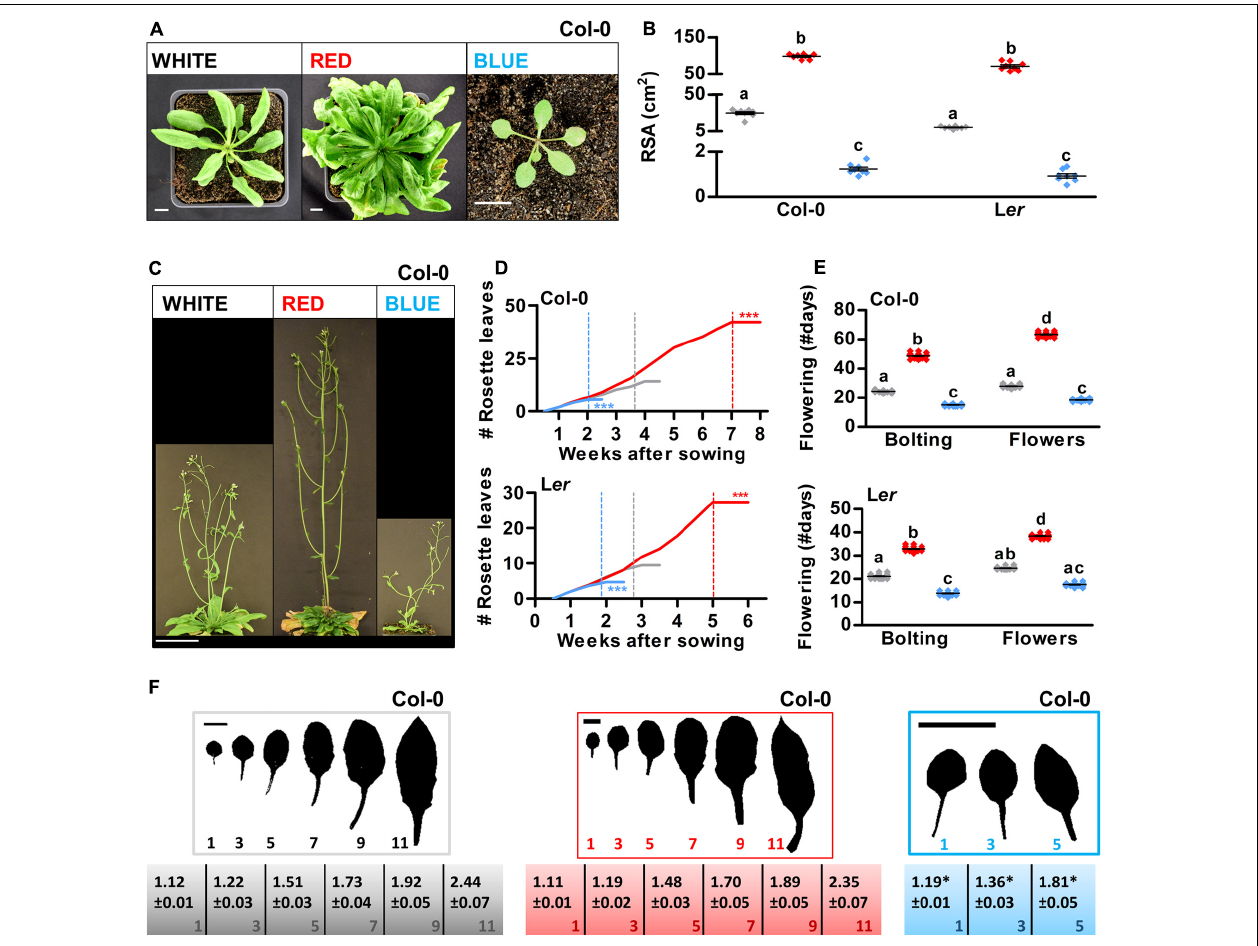
FIGURE 4 | Developmental phase transitions in Arabidopsis are promoted by blue light and delayed by red light. (A) Rosette phenotype of representative Arabidopsis plants of ecotype Columbia (Col-0) grown in white, red, or blue LED conditions. (B) Quantification of rosette surface area (RSA) of Col-0 or Landsberg erecta (L er ) plants as shown in ( A and Supplementary Figure S4B ), respectively. (C) Representative Arabidopsis Col-0 plants grown in LED conditions until 1 week after flowering. (D) Rosette leaf appearance in Col-0 and L er plants over time. (E) Flowering time (until bolting, or until the appearance of flower buds) of Col-0 and L er plants in number of days. (F) Rosette leaves of representative Col-0 plants and length/width ratios of the leaf blade ( ± SE, n = 10). Scale bars represent 1 cm in (A , F) , and 10 cm in (C) . Graph colors represent the LED conditions in (B,D,E) . LED conditions and ecotypes were compared using a one-way ANOVA followed by a Tukey’s test (letters a–d indicate statistically significant differences, p < 0.05) in (B,E) . In (D,F) , monochromatic LED conditions (red or blue) were compared to white (control) using a two-sided Student’s t -test [asterisks indicate significant differences (* p < 0.05, *** p < 0.001)]. Error bars represent standard error of the mean in (B,E) ( n = 30), standard errors for (D) are listed in Supplementary Table S2 ( n = 30). Dashed lines in (D) represent the time of bolting. Similar results were obtained in two independent